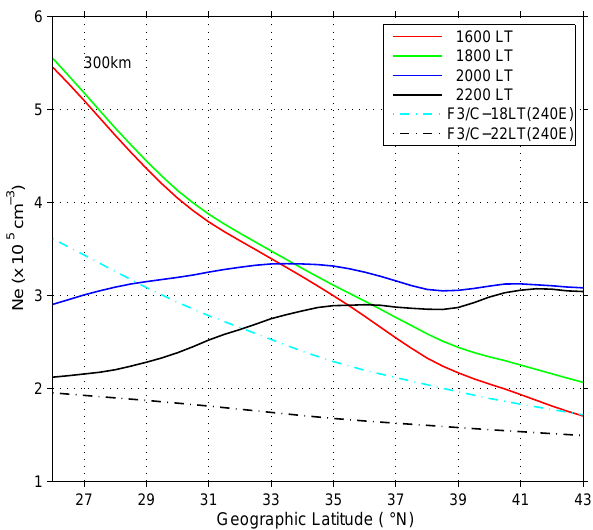
Fig. 4. Latitudinal variation of electron density at 300km, for differ- ent LTs, obtained from tomography. The F3/C observations of the latitudinal variation of electron density at 300km, along the 240 ◦ E sector are also